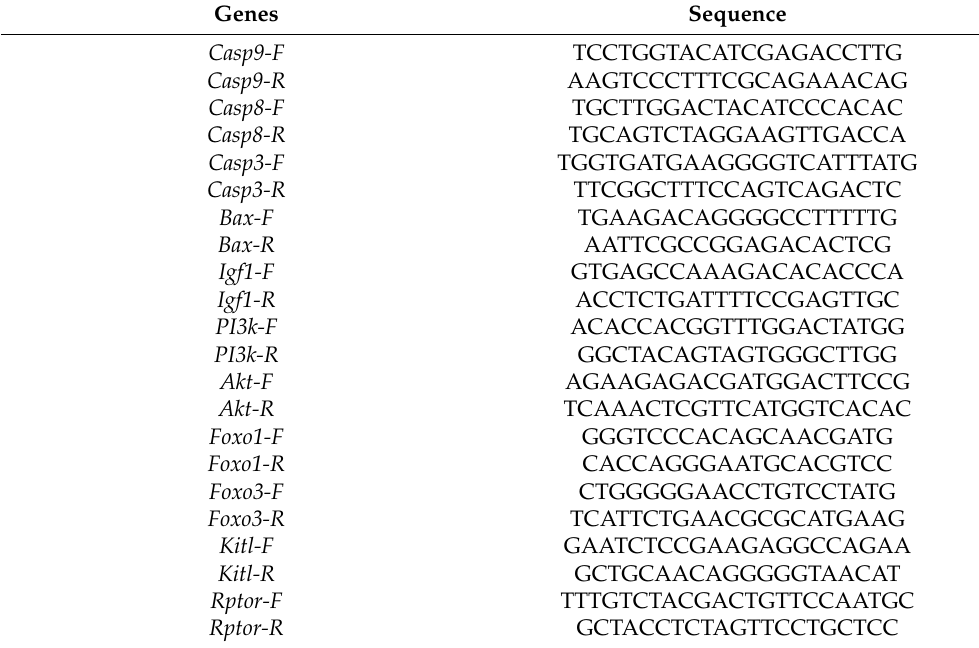
Table 1. Primers for